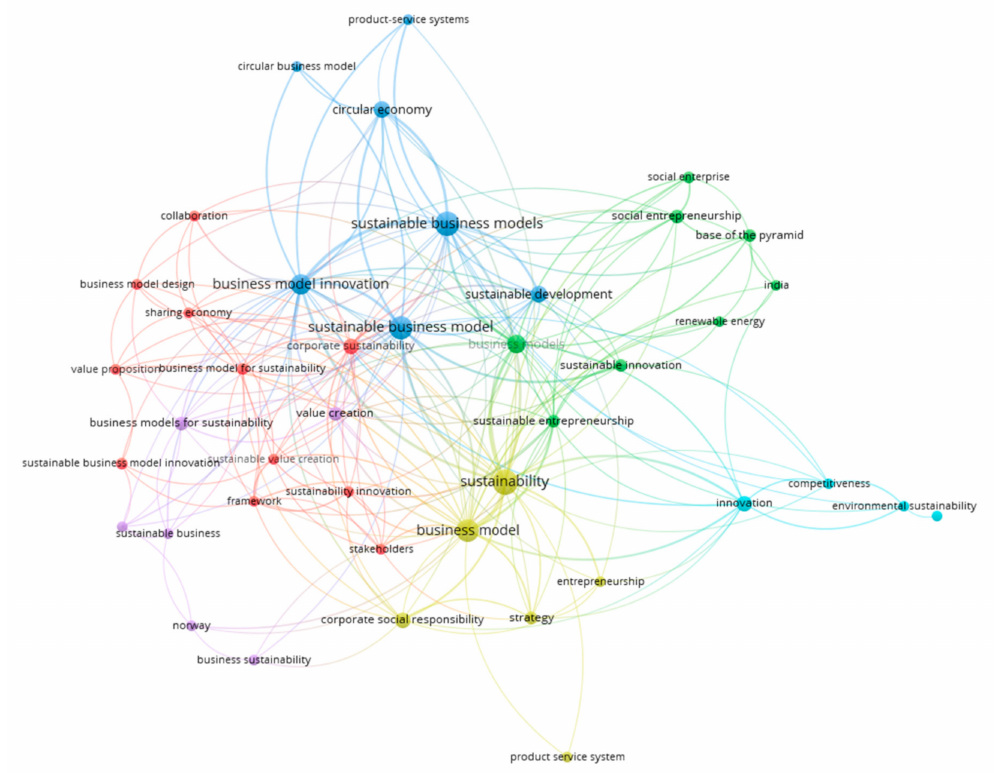
Figure 8. Co-occurrence of authors keywords of publications released in sustainable business models’ research. Source: own elaboration based on the VOSviewer